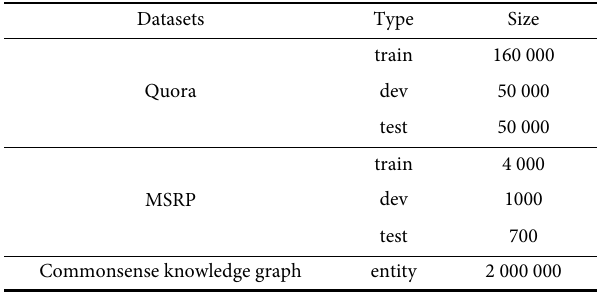
Table 1 Experiment datasets.